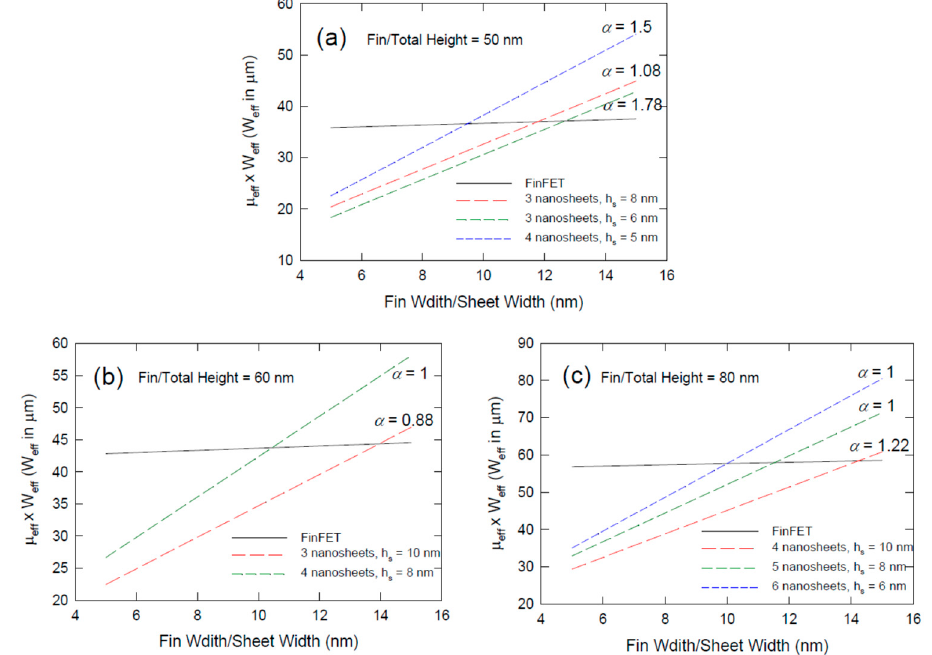
Figure 5. Plots of effective mobility-effective channel width product as a function of fin width or sheet width for FinFET and VNSFET for headroom of ( a ) 50 nm; ( b ) 60 nm; and ( c ) 80 nm.